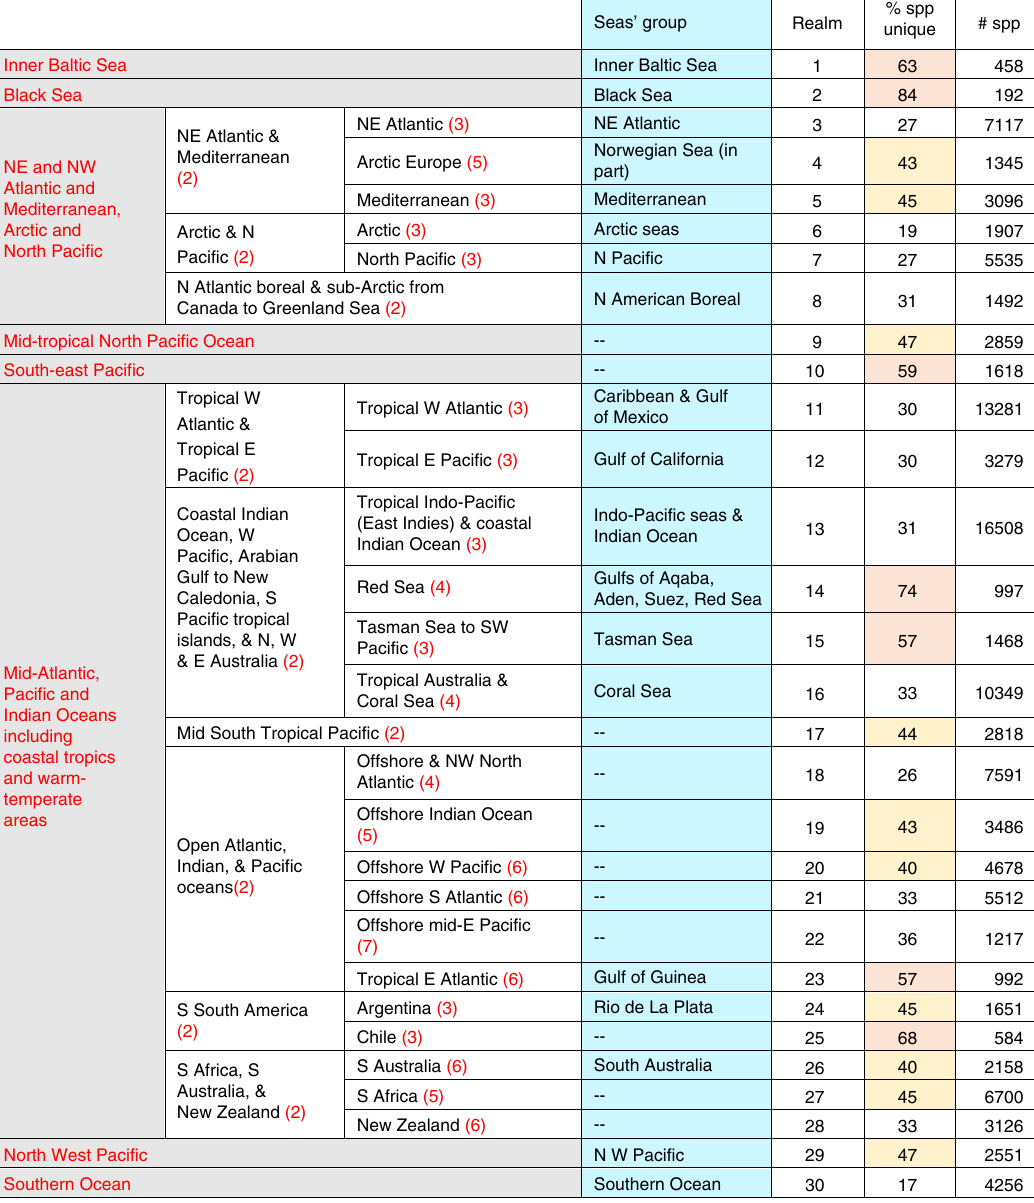
Fig. 1 Classi fi cation hierarchy and number of species belonging to the mapped biogeographic realms. The classi fi cation hierarchy from this analysis is compared to the clustering of seas and oceans as shown on a blue background. The red text in column 1 denotes the realms de fi ned by pelagic-only species and clustered at 1% similarity. The red numbers in parentheses in columns 2 and 3 indicate further similarity index levels, e.g., 3 = 3% similarity between 5 o areas in that region. The percentage of unique species indicates how distinct the realm was from the others; cells with yellow background represent > 40%, while cells with peach colored background represent > 50%. Comparisons with previous studies are in Supplementary Table 7. E, east; N, north; S, south; Spp, species; W,